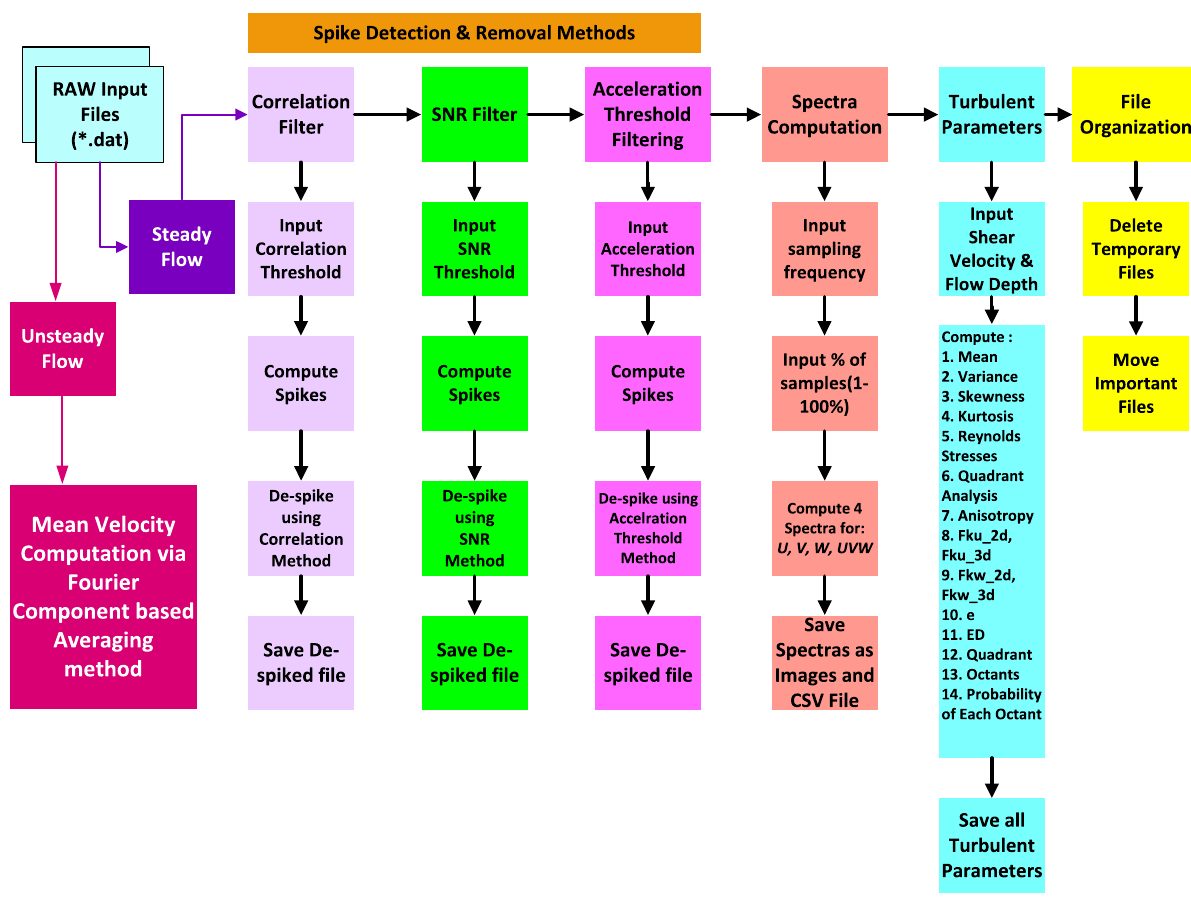
Figure 2. Flow diagram of the P-SAT